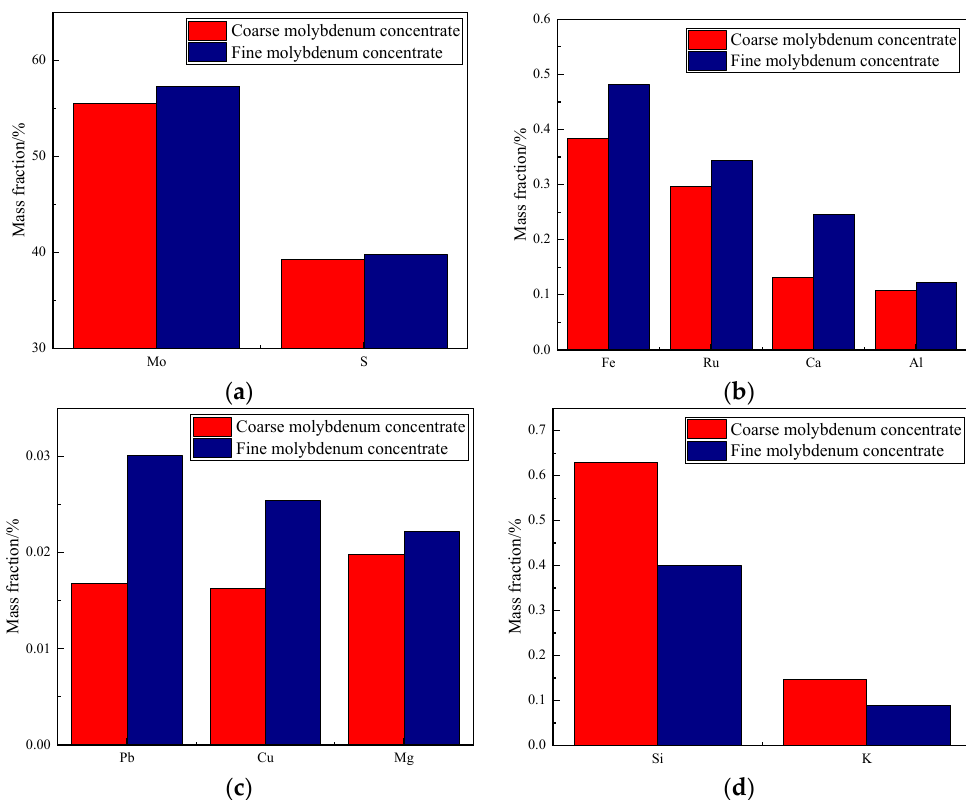
Figure 2. Distribution of elements in molybdenum concentrates with different particle sizes. ( a ) Content of Mo, S; ( b ) Content of Fe, Ru, Ca, Al; ( c ) Content of Pb, Cu, Mg; ( d ) Content of Si, K.